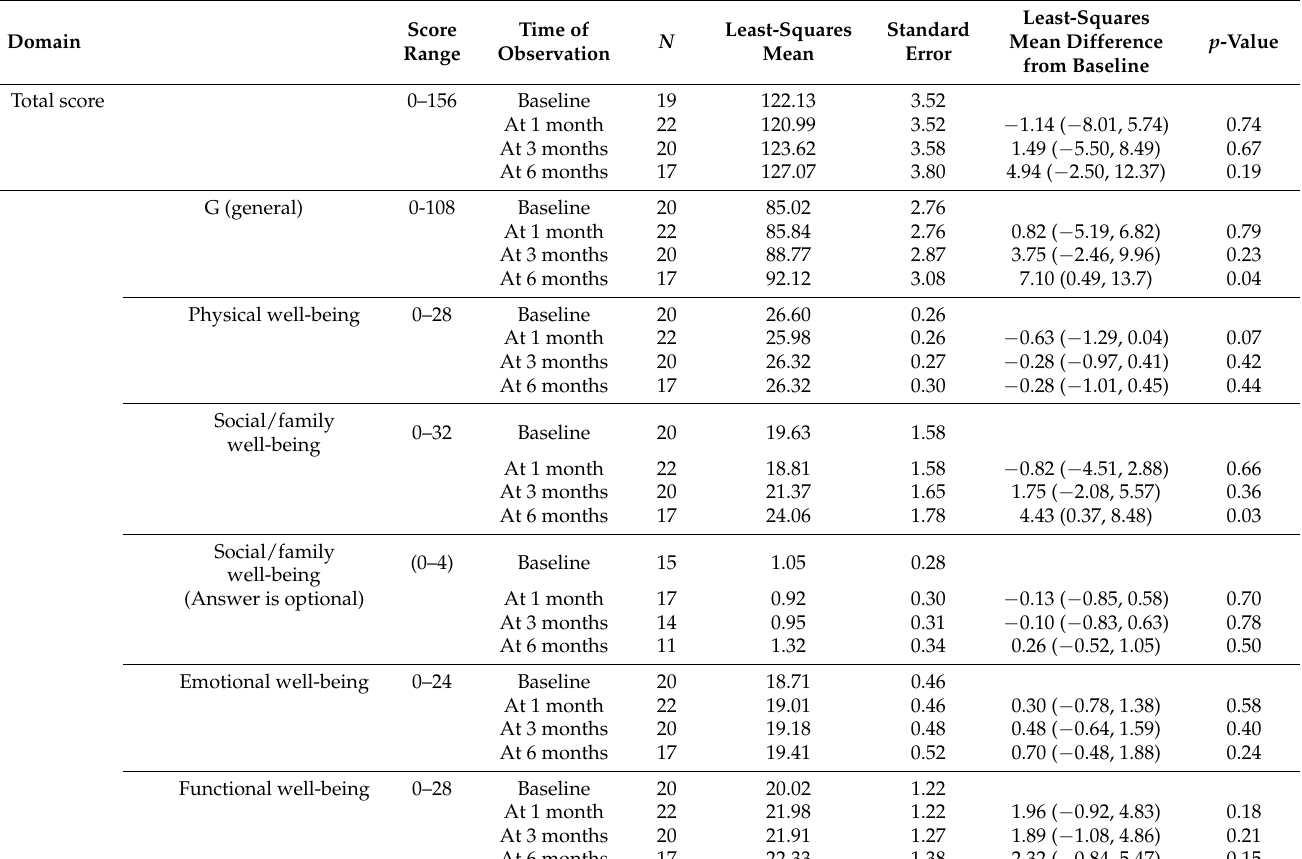
Table 4. Changes from baseline of the Functional Assessment of Cancer Therapy-Prostate (FACT-P)